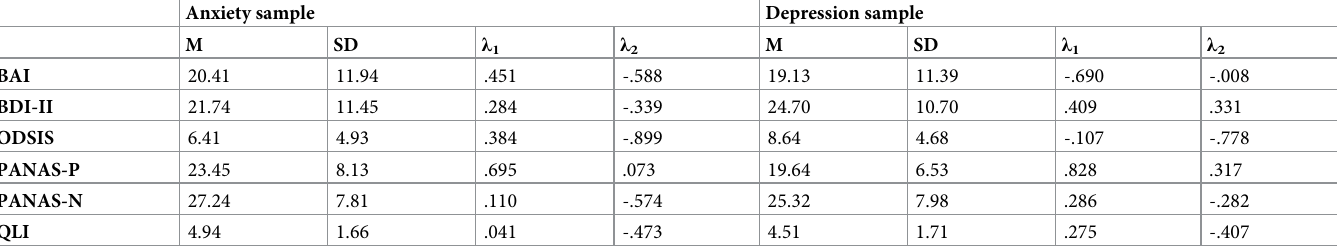
Table 3. Descriptive statistics for convergent and discriminant validity measures in depressive and anxiety disorder samples. Anxiety